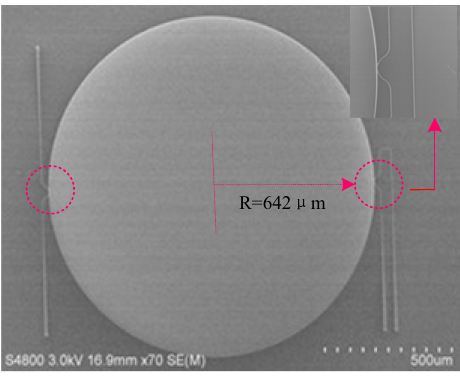
Figure 9. Scanning-electron-microscopy (SEM) of silicon-on-insulator (SOI) ring resonator.